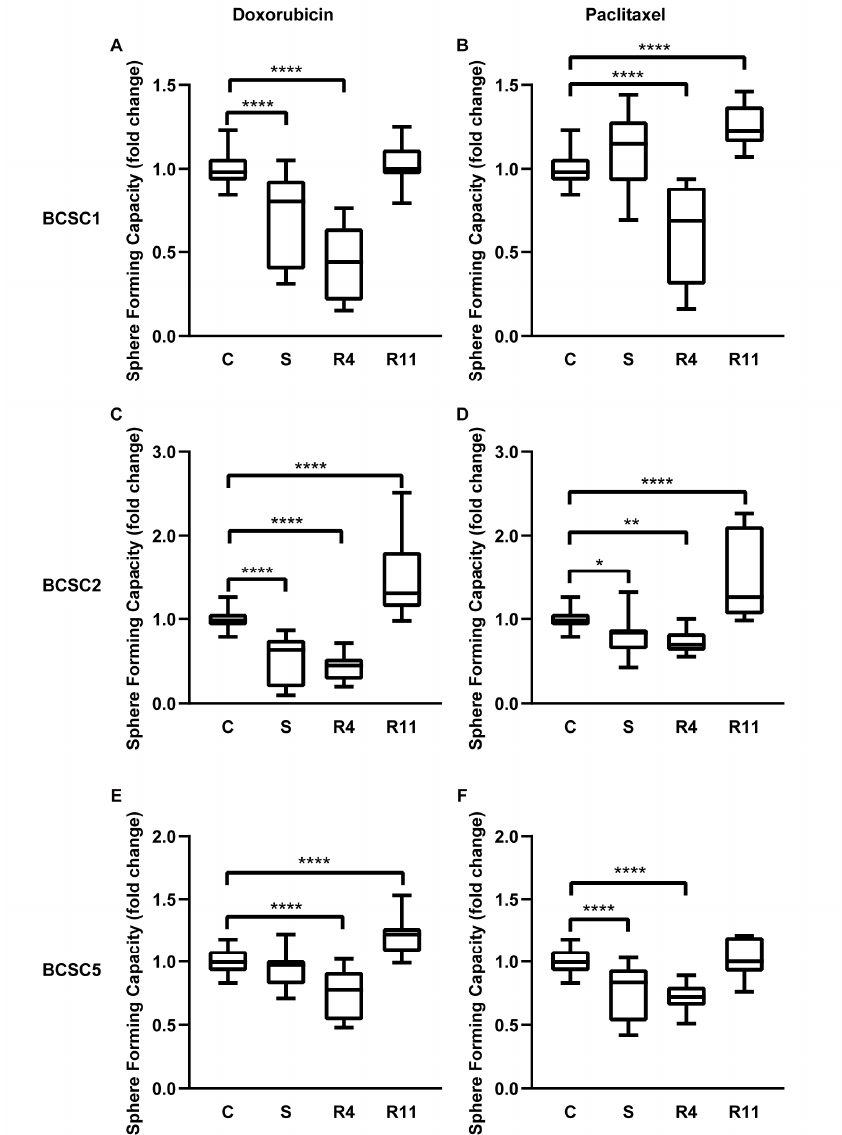
Figure 5. Chemotherapeutic stress enhanced the self ‐ renewal capacity of the BCSCs. ( A – F ) Sphere ‐ forming capacity of untreated control BCSCs (C), surviving BCSCs (S), and recovered BCSCs (R4, R11). Data in graph represent relative sphere ‐ forming capacity compared with untreated control cells, n = 3. Box plots demonstrate median, lower, and upper quantile range (box lines), and standard deviation range (lines bounded by horizontal lines outside the boxes). * = p < 0.05; ** = p < 0.01; **** = p < 0.0001 by one ‐ way